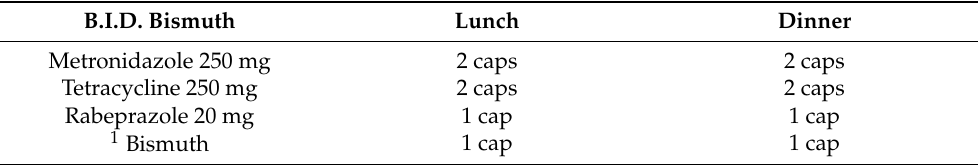
Table 1. Dosage and schedule of treatment given for 10